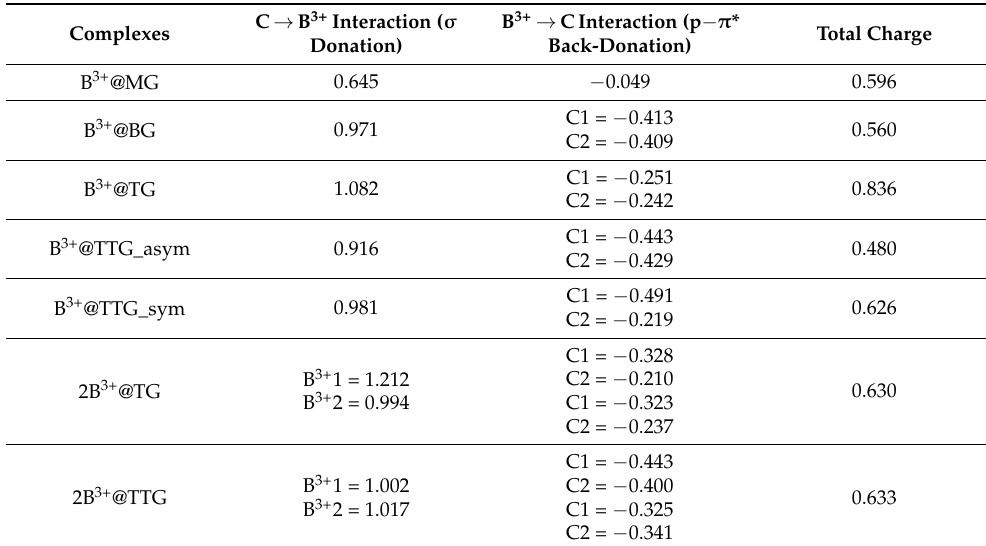
Table 1. Summary of NBO analysis of π -complexation between B 3+ ions and the graphene sheets.